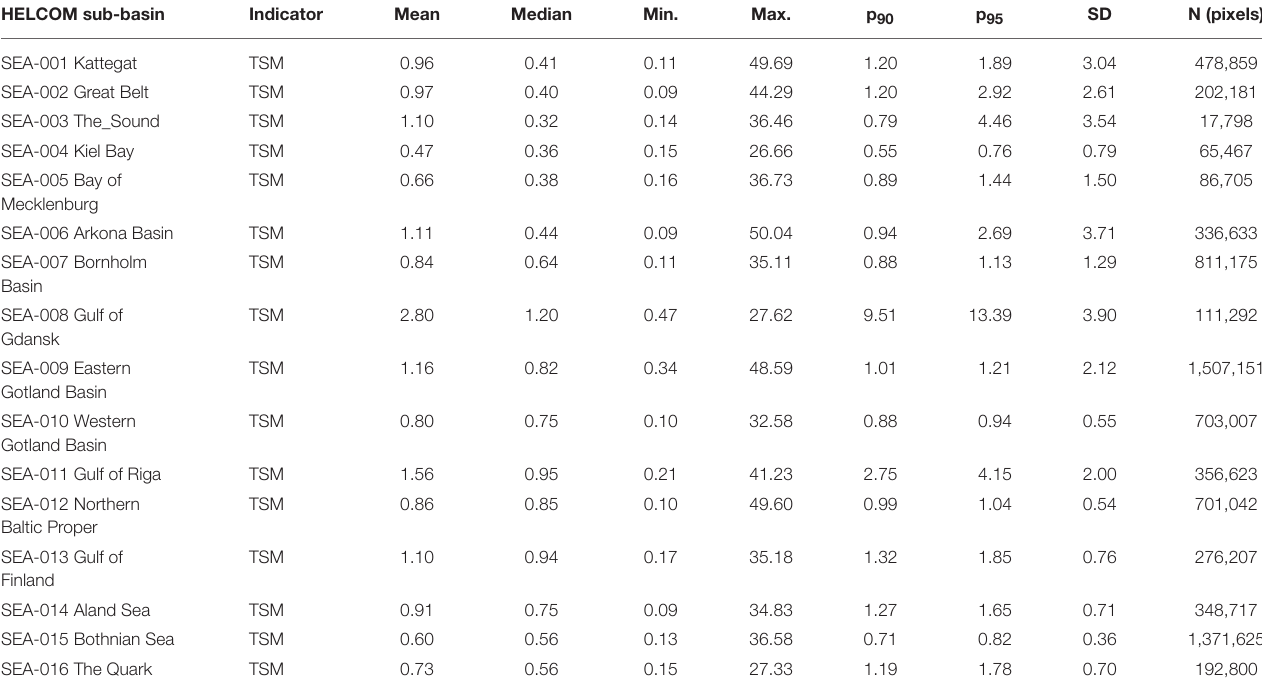
TABLE 3 | TSM concentration per sub-basin derived from a 3-year TSM summer composite. HELCOM sub-basin Indicator Mean Median Min. Max. N